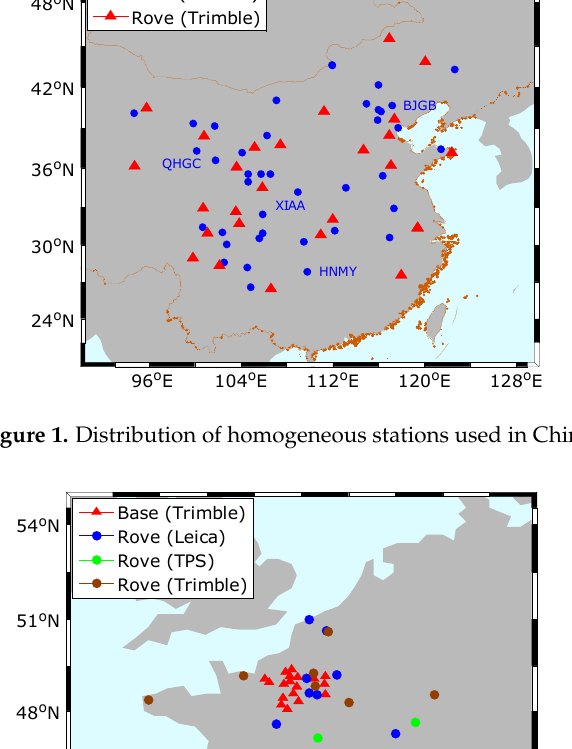
Figure 1. Distribution of homogeneous stations used in China.